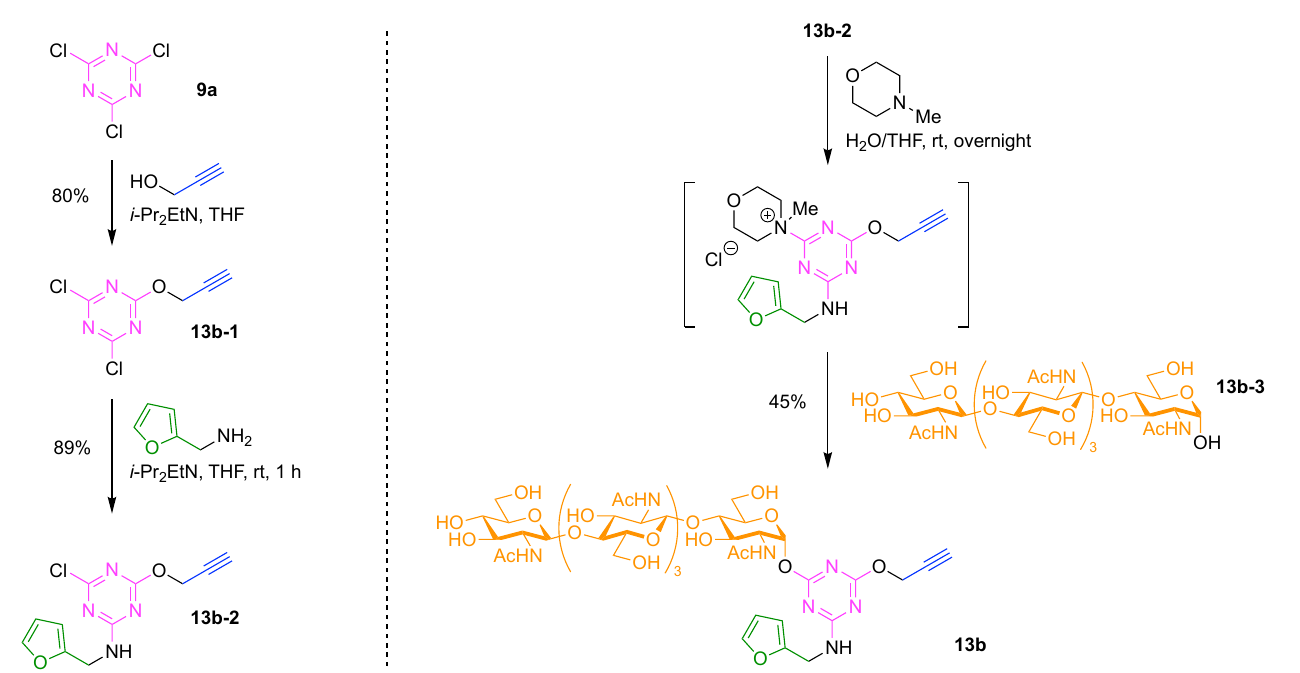
Figure 63. Synthesis of an affinity labeling probe for carbohydrate-binding proteins. Compound 13b was used for affinity labeling of a chitin pentaose-binding protein, wheat germ agglutinin. Triazinylation of a nucleophilic residue in the protein was proposed to occur with release of chitin pentaose as a leaving group. The labeling of the protein was detected after treatment with azido-fluorescein, which attaches fluorescein to the alkyne (Unit B). Further study is necessary to quantify the protein labeling and to determine the position of the labeled amino acid residue(s).